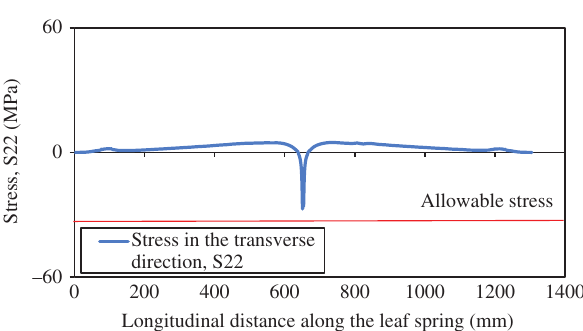
Figure 9: S22 stress distribution on the glass and carbon fiber/epoxy leaf spring upper surface along the longitudinal